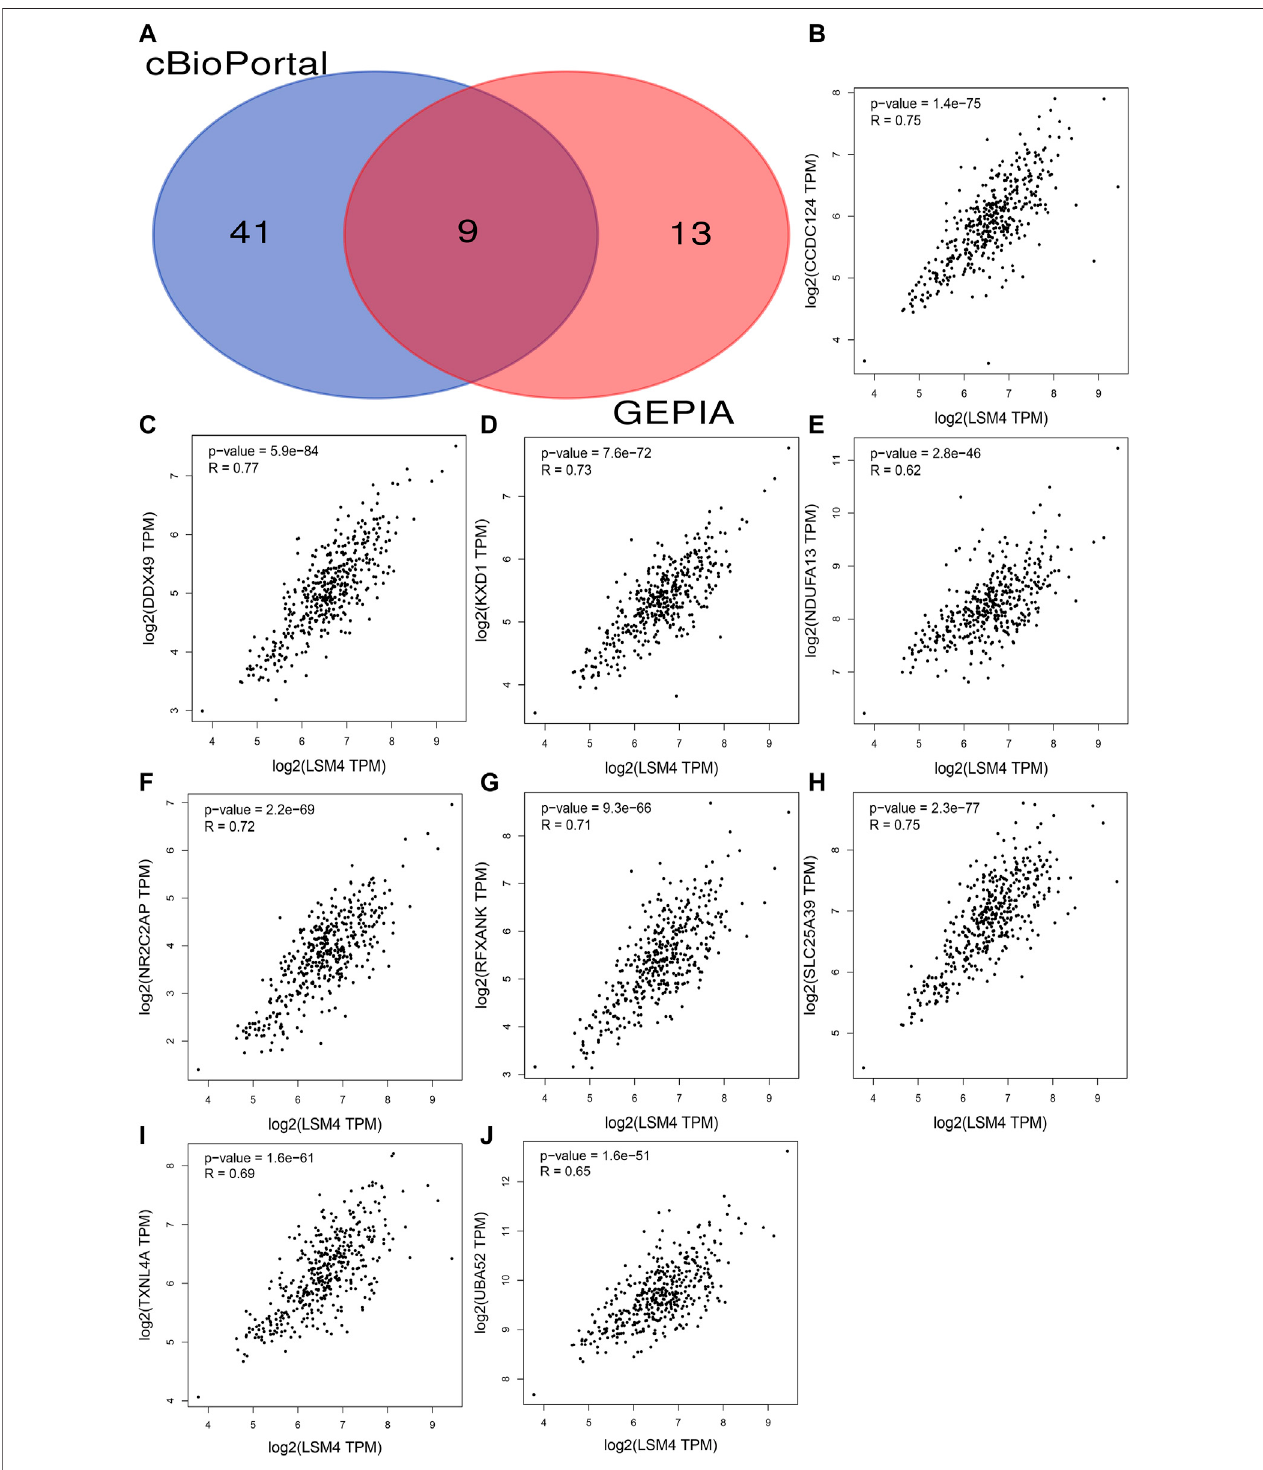
FIGURE8| Identi fi cationco-expressedgenes(CEGs)of LSM4 inhepatocellularcarcinoma.Venndiagramforthenineintersectiongenesof LSM4 positivelyrelated CEGs identi fi ed by the cBioPortal and the GEPIA databases (A) . The scatter plot shows the signi fi cant positive correlation between LSM4 and nine CEGs (B – J) .